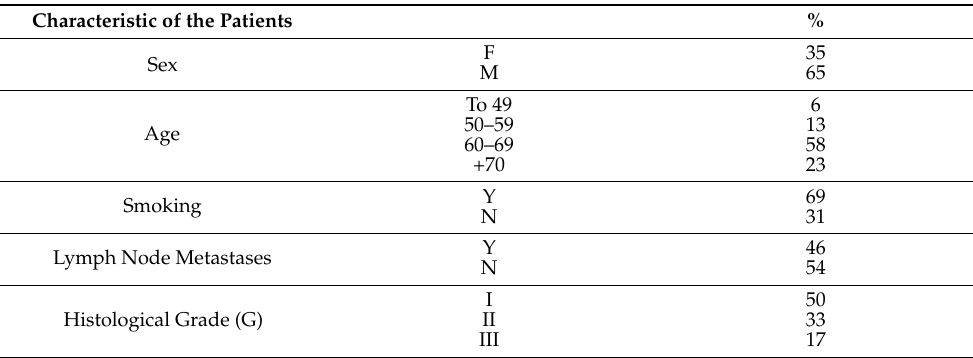
Table 1. Characteristic of the patients include sex, age, smoking habits, presence of metastases in the lymph nodes, and histological grade of carcinoma.